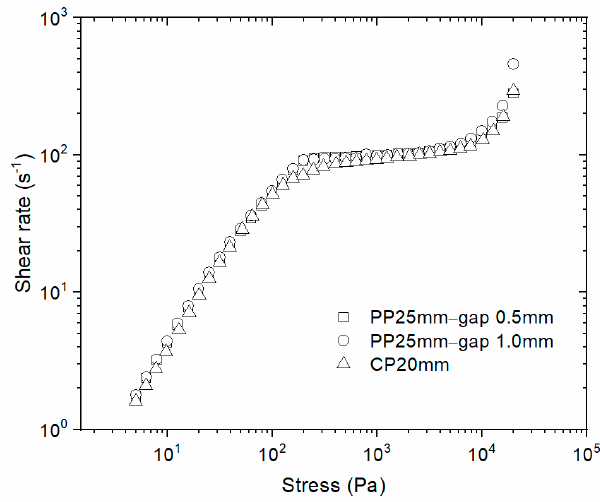
Figure 1. Steady flow curve of 24 wt% hydrophobic fumed silica R816 in PPG400 suspensions obtained using CP (20 mm/1°) and PP (25 mm and two gaps, 0.5 and 1 mm) geometries. The coincidence of shear rates at the different shear stress values imposed to the sample is an indication of absence of wall-slip according to the prediction of Equation (1).